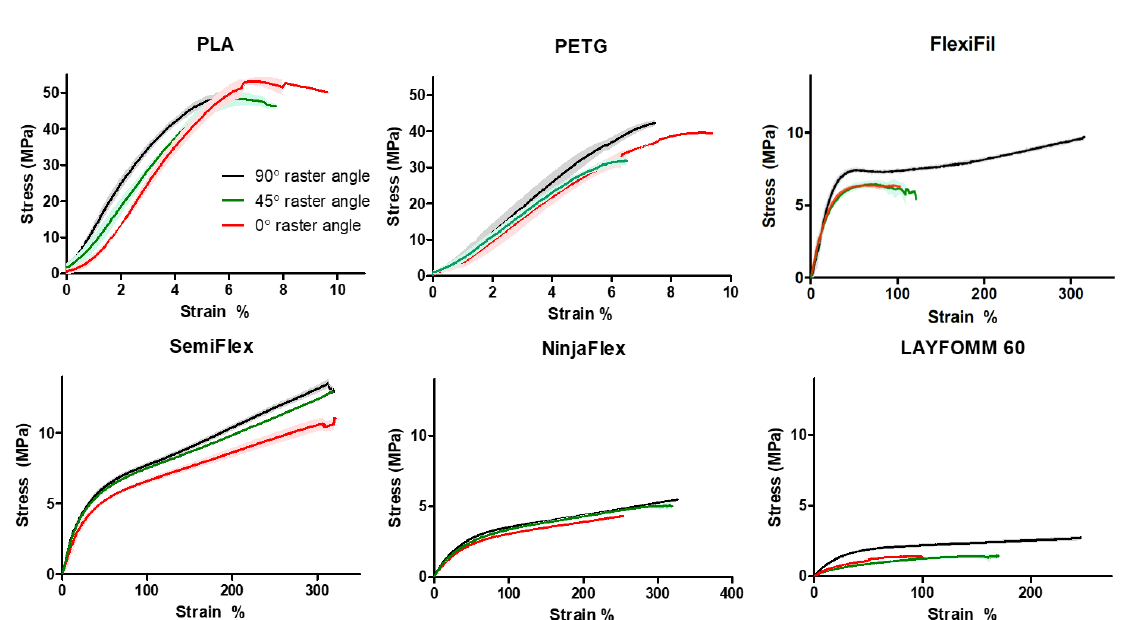
Figure 3. Stress–strain curves for all materials ( n = 3) at each raster angle. Shaded zones around plot lines indicate the mean ± SD. In some samples, error bars (SD) are too small to be displayed.